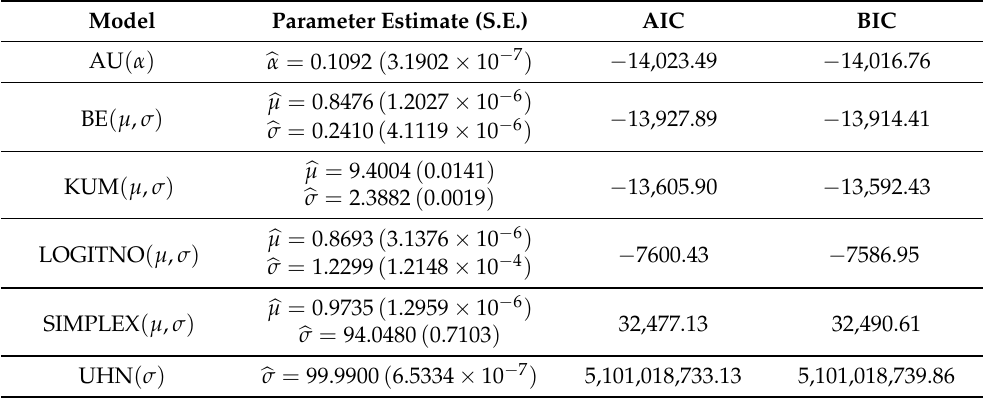
Table 3. Parameter estimates, AIC and BIC values (relative air humidity data).